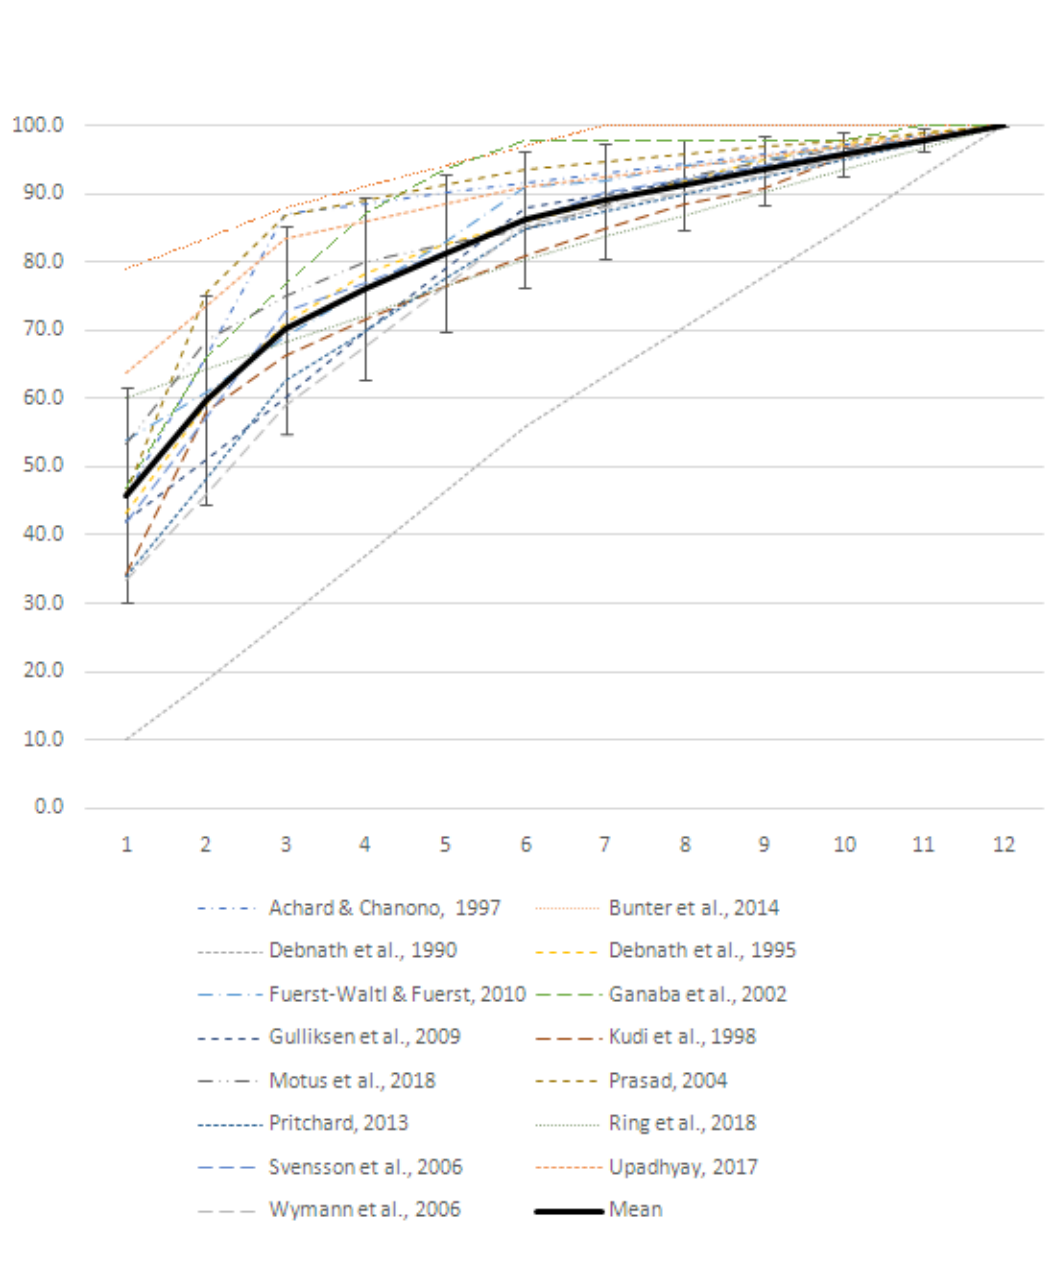
Figure 3. Cumulative mortality in calves between 0 - 12 months of age. This graph shows includes 15 studies reporting mortality distribution by age for at least the 12 months of age. The black line shows the mean cumulative mortality with standard deviation bars. On average, 86% of mortalities in the first 12 months had already occurred by six months of